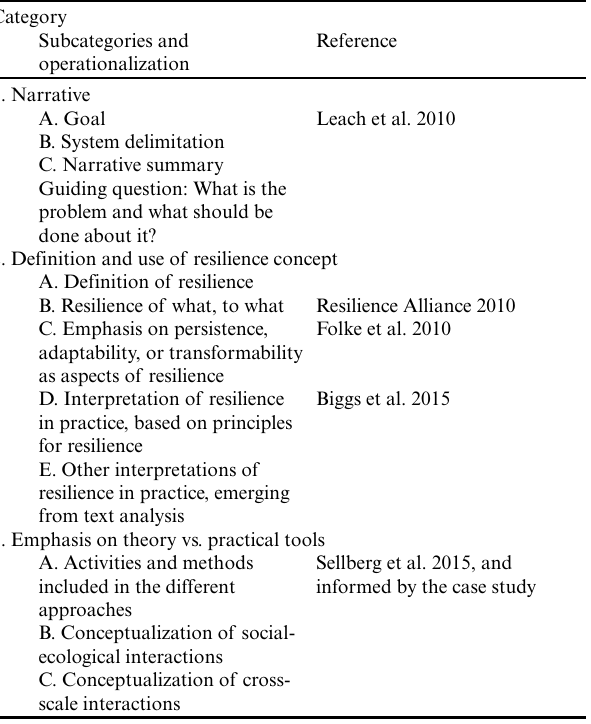
Table 1 . Framework for the qualitative text analysis comparing handbooks of the Transition Movement approach (Hopkins 2008, 2011) and the Resilience Assessment approach (Resilience Alliance 2010). Numbers and letters refer to the categories in